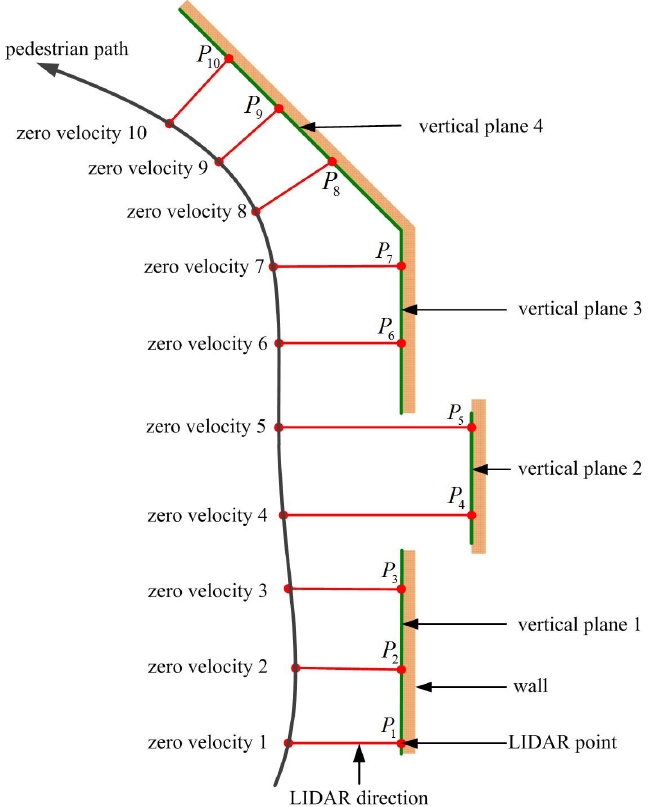
Figure 2. Vertical plane detection using